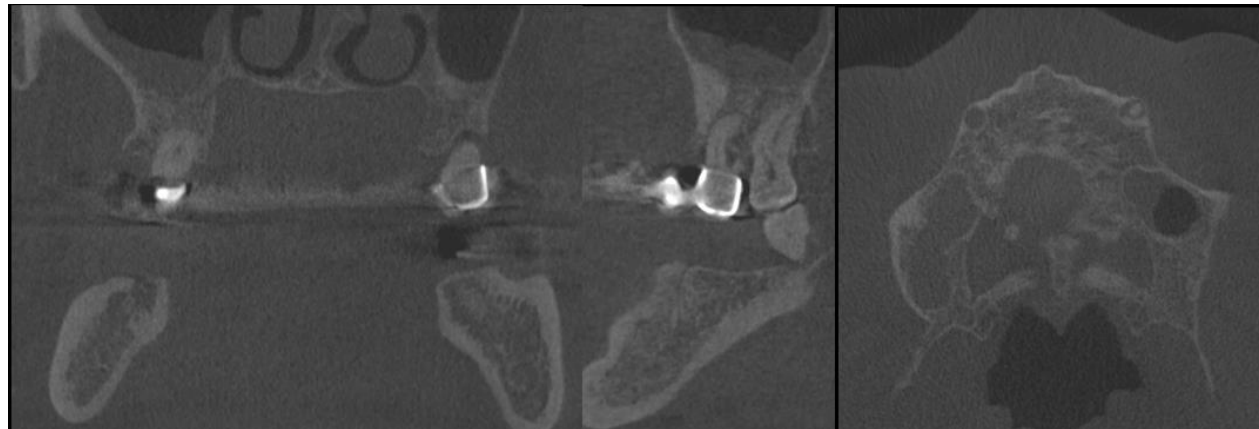
Figure 3. CBCT with visible sources of dental infection. CBCT scans: coronal, sagittal, and axial.